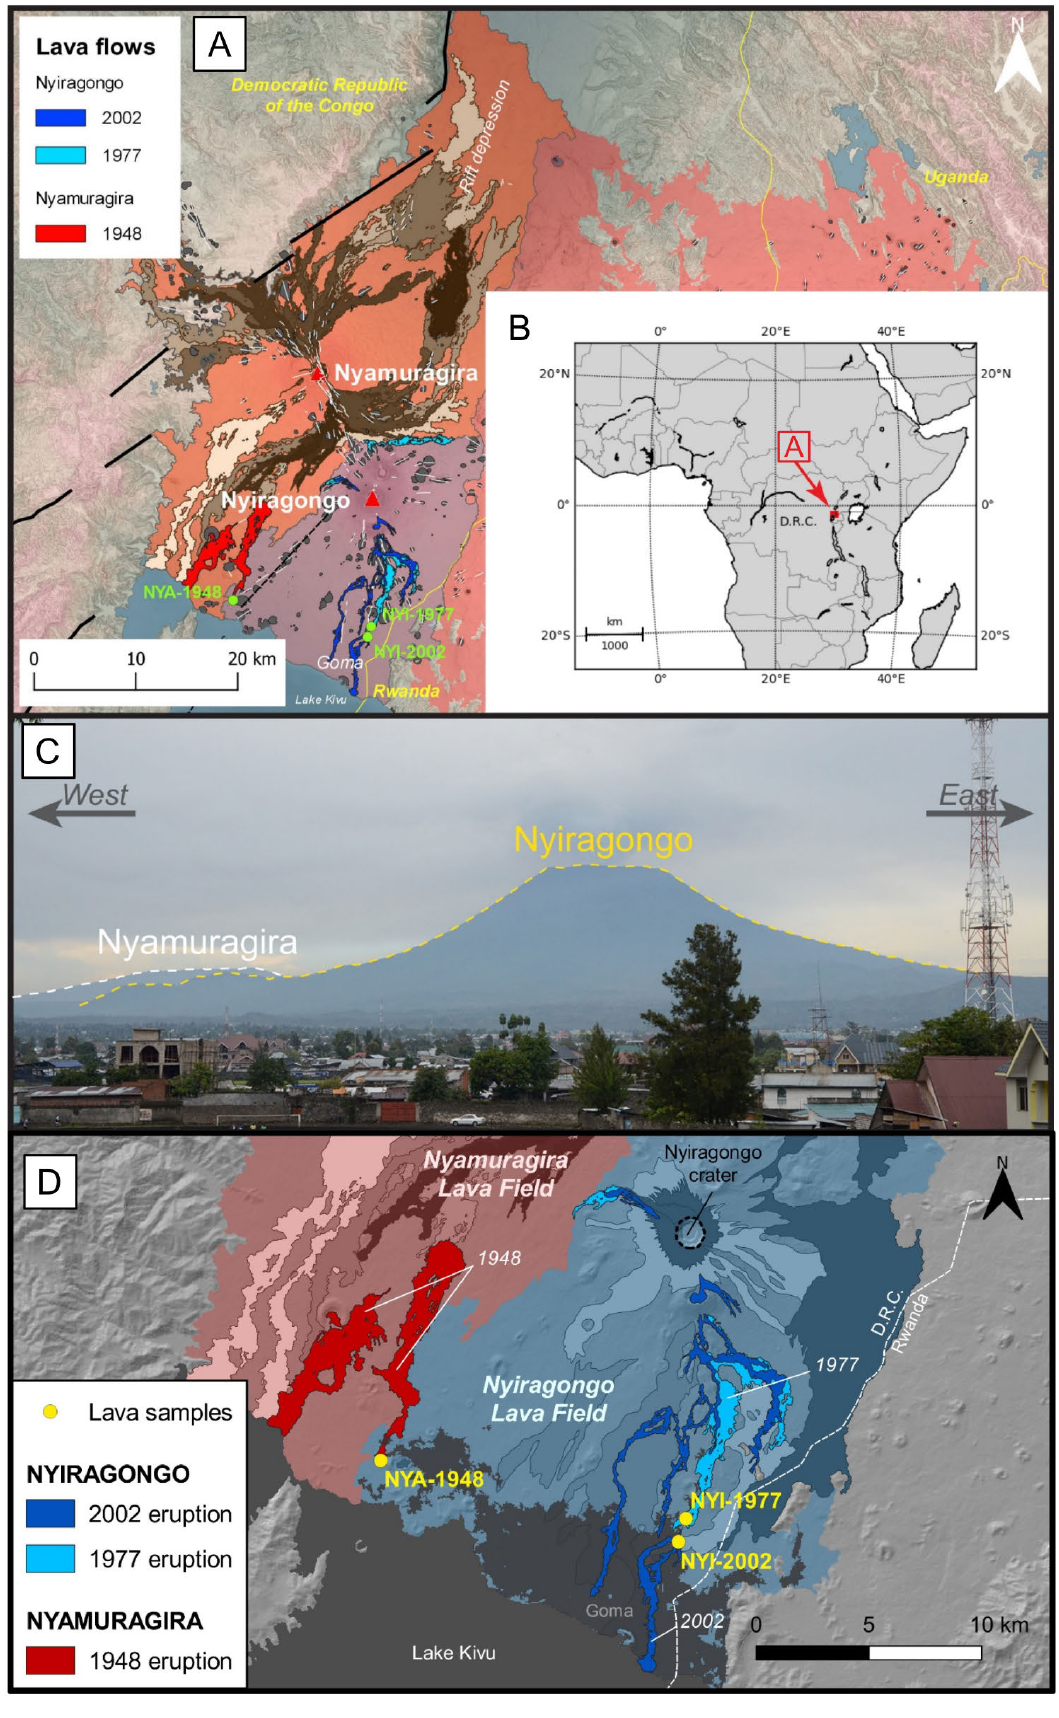
Figure 1: (Caption next